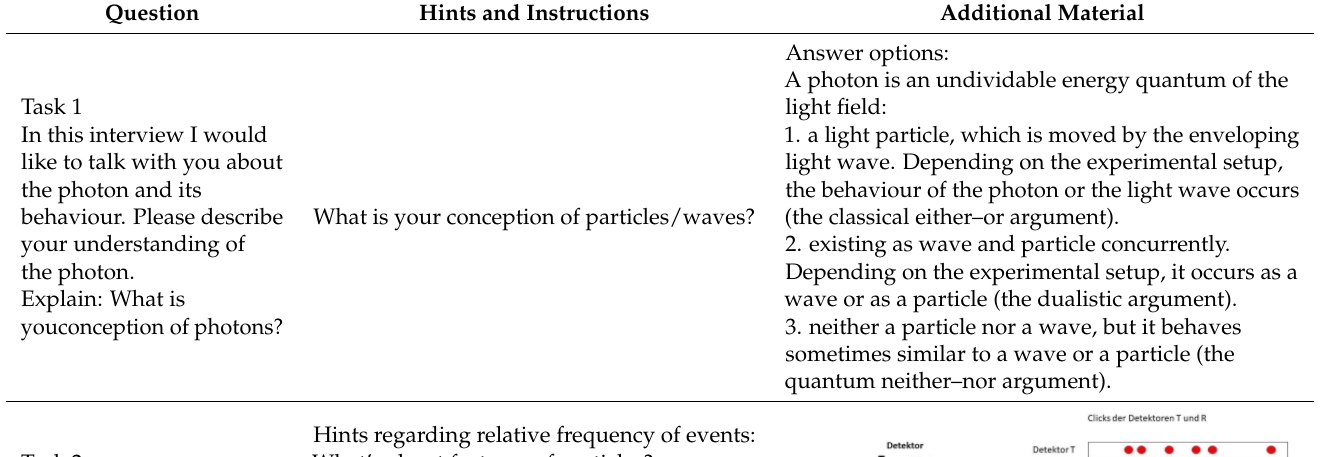
Table 3. Guidelines for the